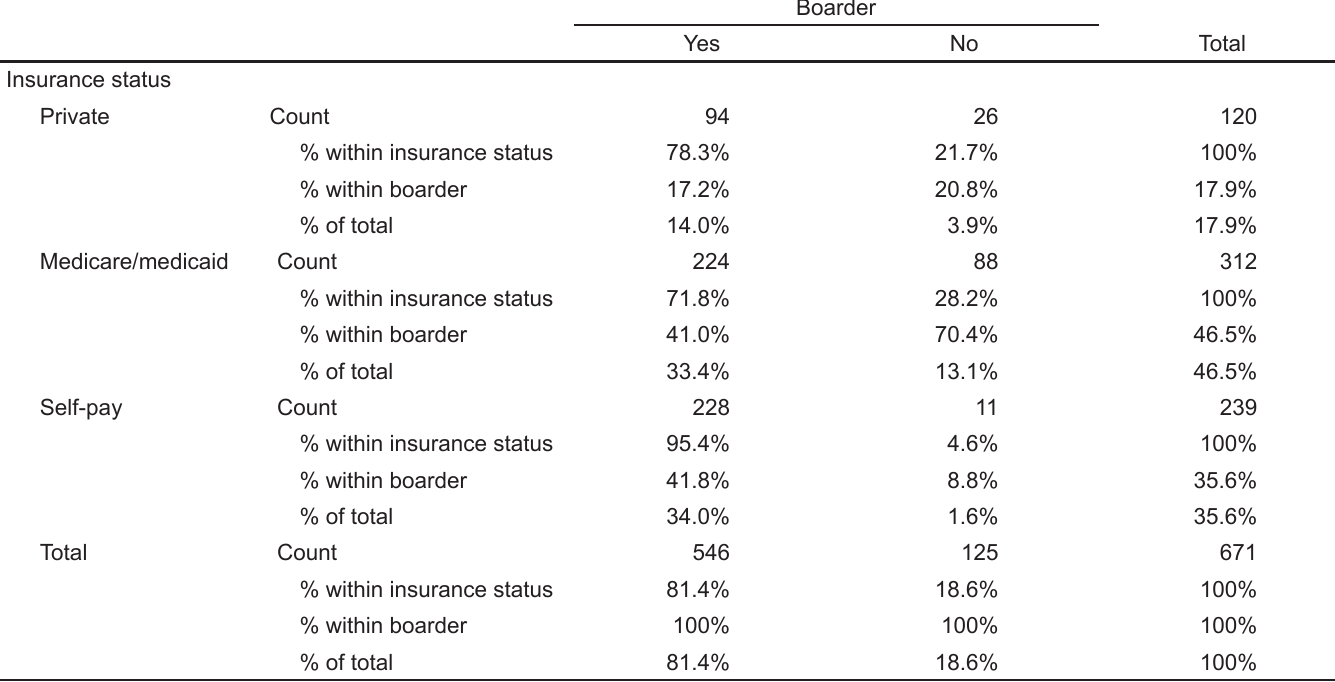
Table 1. Insurance effect on psychiatric boarding in the emergency